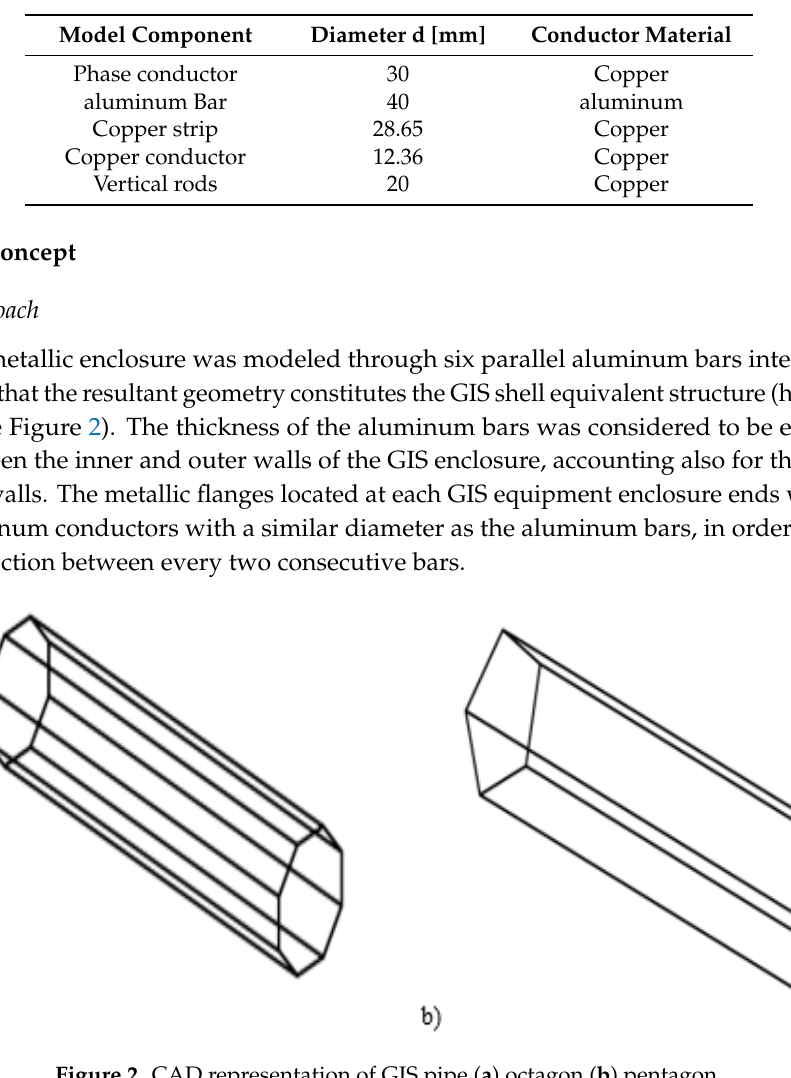
Figure 2. CAD representation of GIS pipe ( a ) octagon ( b ) pentagon.